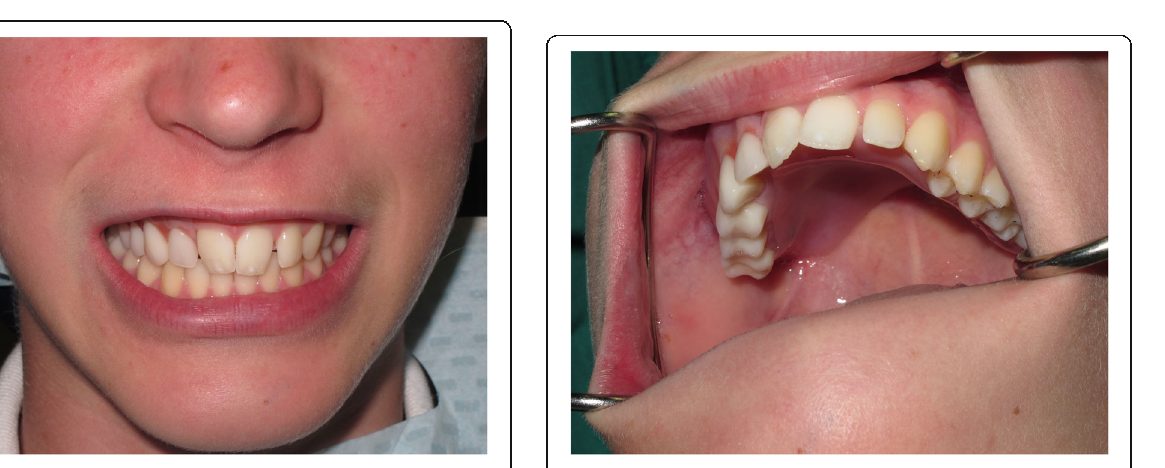
Fig. 9 Palatal view of definitive implant-retained obturator at